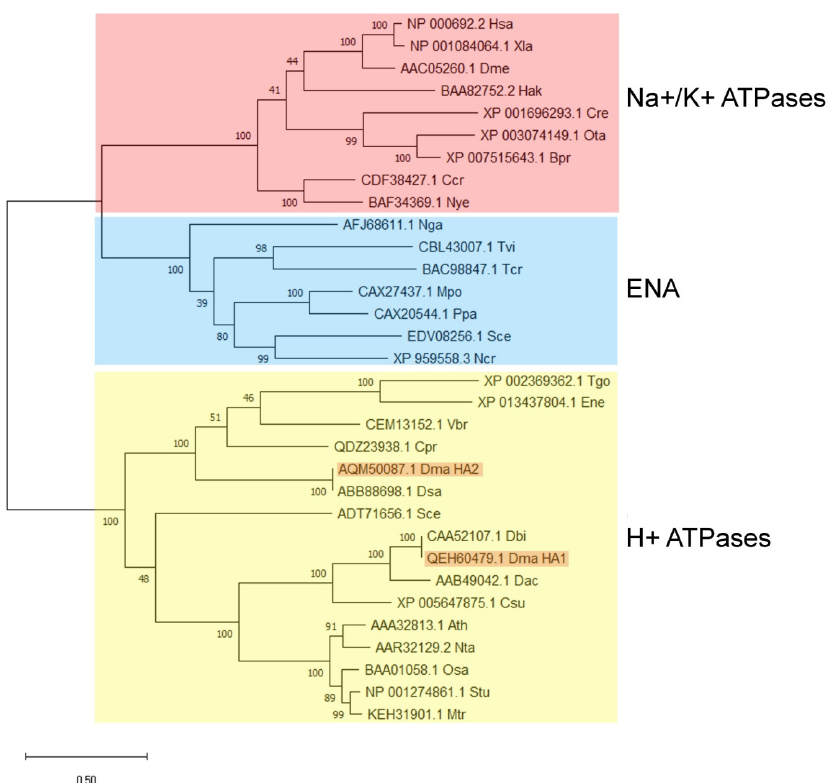
Figure 2. Cladogram of P-type H + -ATPases and Na + -ATPases from different organisms. Amino acid sequences from the following organisms are included in the analysis: Ath, Arabidopsis thaliana ; Bpr, Bathycoccus prasinos ; Ccr, Chondrus crispus ; Cpr, Chloropicon primus ; Cre, Chlamidomonas reinhadtii ; Csu, Coccomyxa subellipsoidea ; Dac, Dunaliella acidophila ; Dbi, Dunaliella bioculata; Dma, Dunaliella maritima ; Dme, Drosophila melanogaster ; Dsa, Dunaliella salina ; Ene, Eimeria necatrix ; Hak, Heterosigma akashiwo ; Has, Homo sapiens ; Mpo, Marchantia polymorpha ; Mtr, Medicago truncatula ; Ncr, Neurospora crassa ; Nga, Nannochloropsis gaditana ; Nta, Nicotiana tabacum ; Nye, Neopyropia yezoensis; Osa, Oryza sativa ; Ota, Ostreococcus tauri ; Ppa, Physcomitrella patens ; Sce, Saccharomyces cerevisiae ; Stu, Solanum tuberosum ; Tcr, Trypanosoma cruzi ; Tgo, Toxoplasma gondii ; Tvi, Tetraselmis viridis ; Vbr, Vitrella brassi- caformis ; Xla, Xenopus laevis.